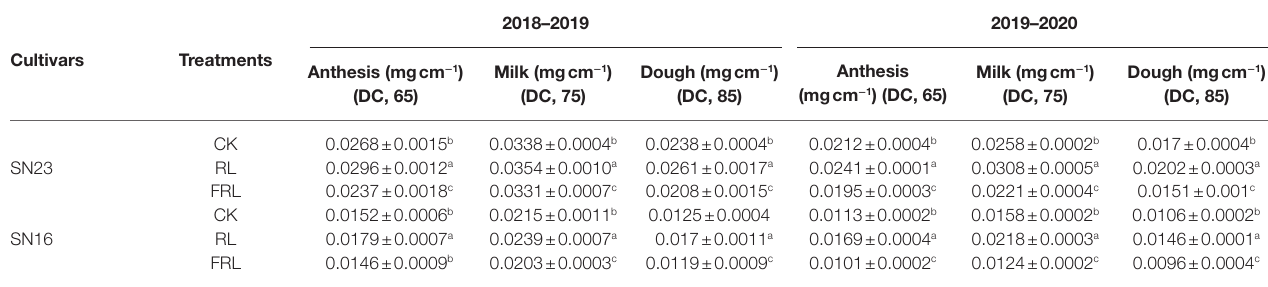
TABLE 4 | The effect of light quality in population on dry weight per length in wheat stem in 2018–2019 and 2019–2020 growing seasons.